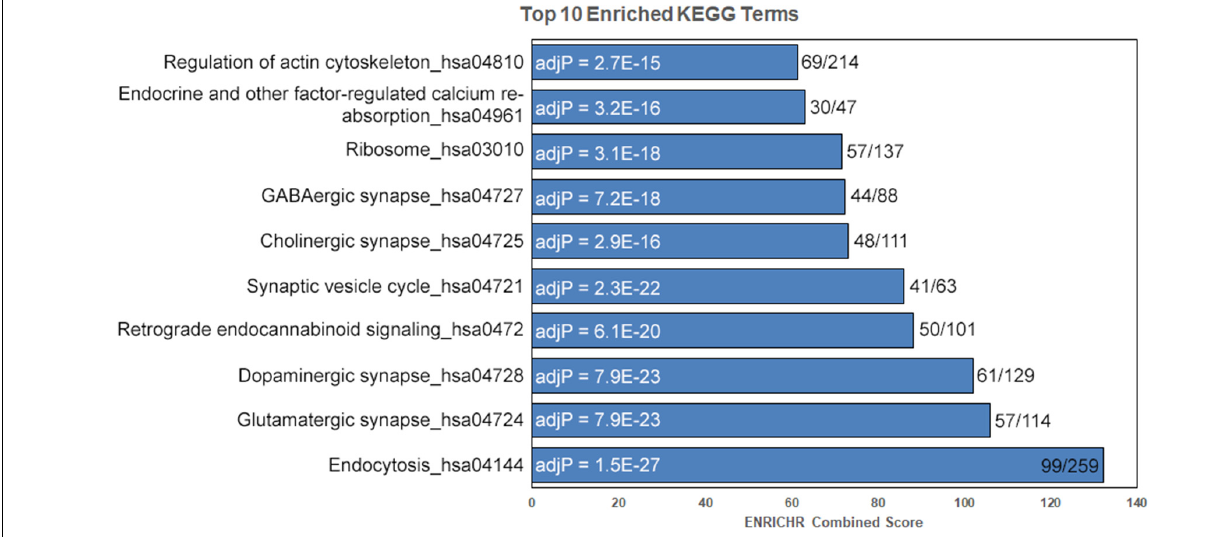
the relationship between baseline striatal protein and mRNA expression, we compared expression of these 160 proteins to striatal mRNA expression generated from many ( ≤ 10) B6 and